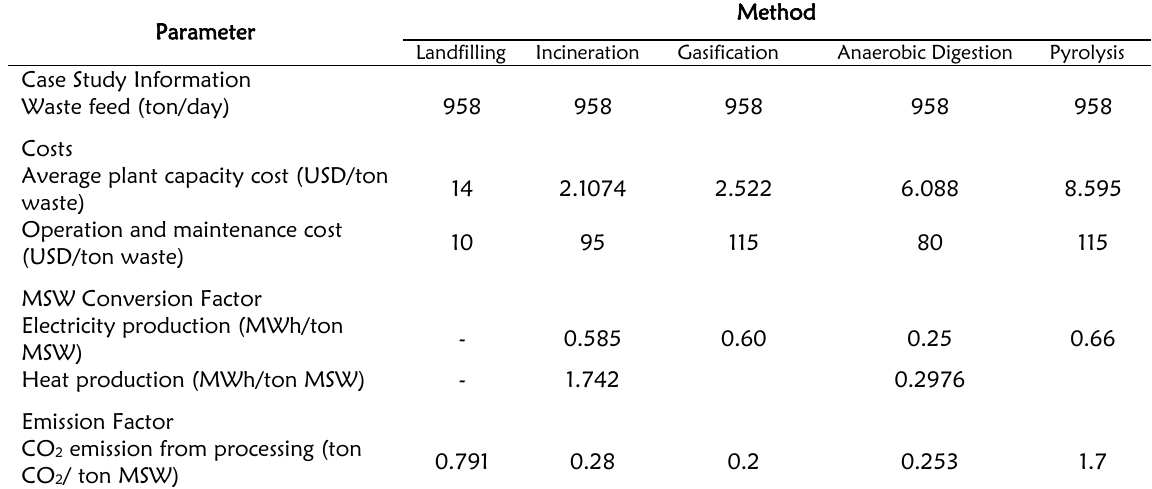
Table 3: Parameters considered for various WTE technologies in Chattogram city [19]